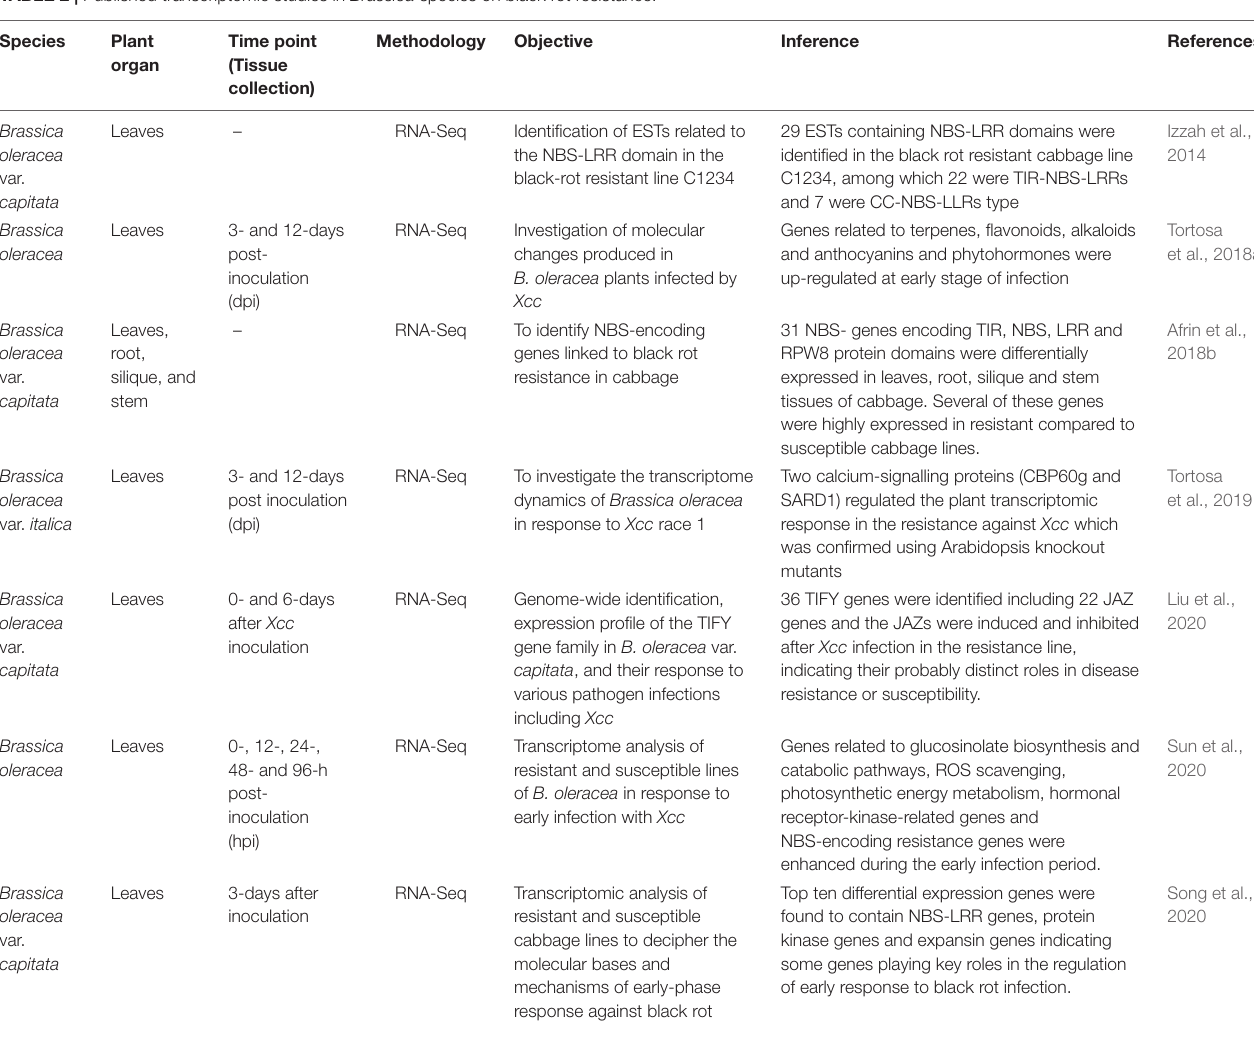
TABLE 2 | Published transcriptomic studies in Brassica species on black rot